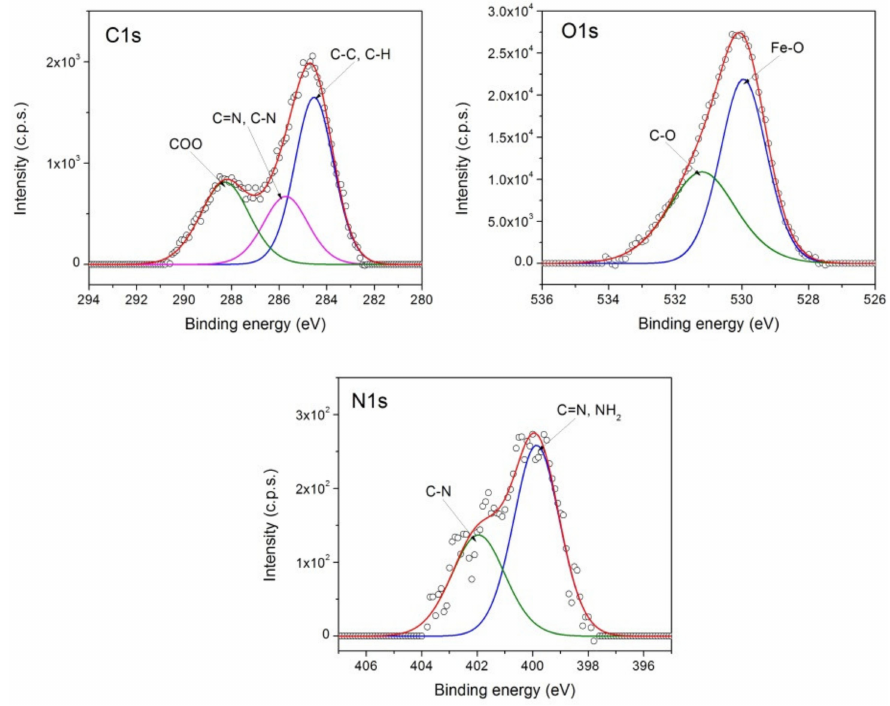
Figure 8. High-resolution XPS spectra of C1s, O1s and N1s core-levels for